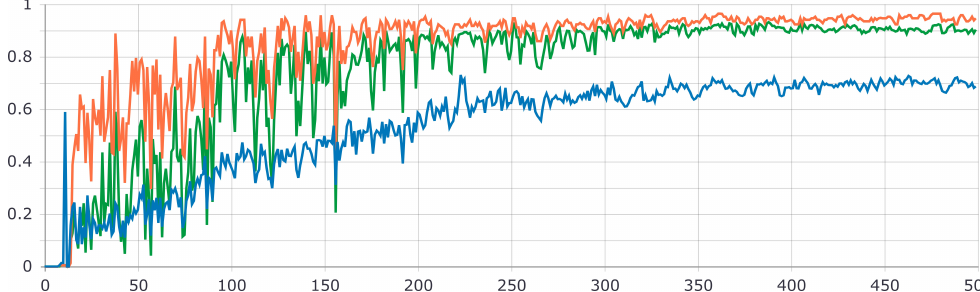
Figure 11. Training process for grapevine moth males detection and classification: mAP@0.5 (green), precision (blue) and recall (orange)